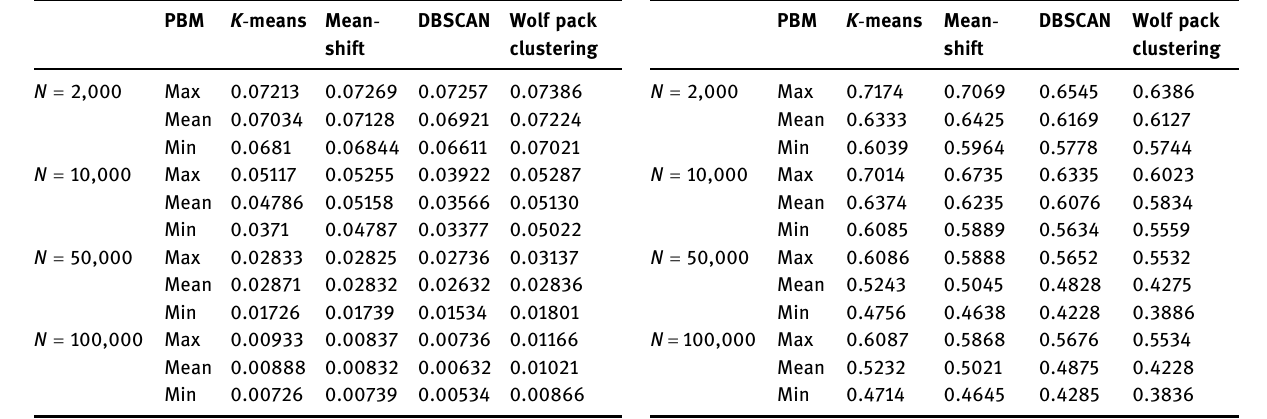
Table 1: PBM performance with di ff erent sample sizes when P = 10